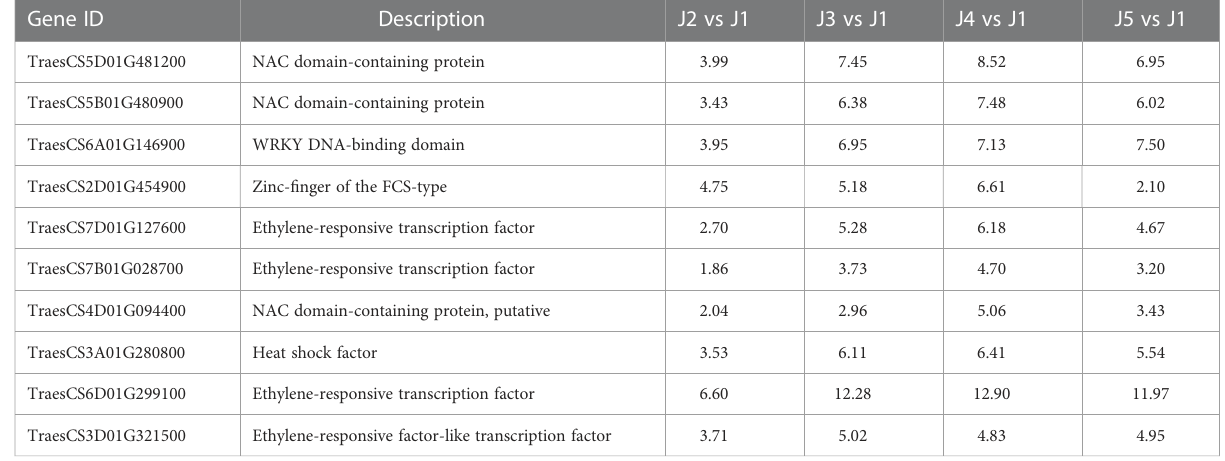
TABLE 6 Representative mostly up-regulated TFs common at all time points, shown as log2 value of fold changes. Gene ID